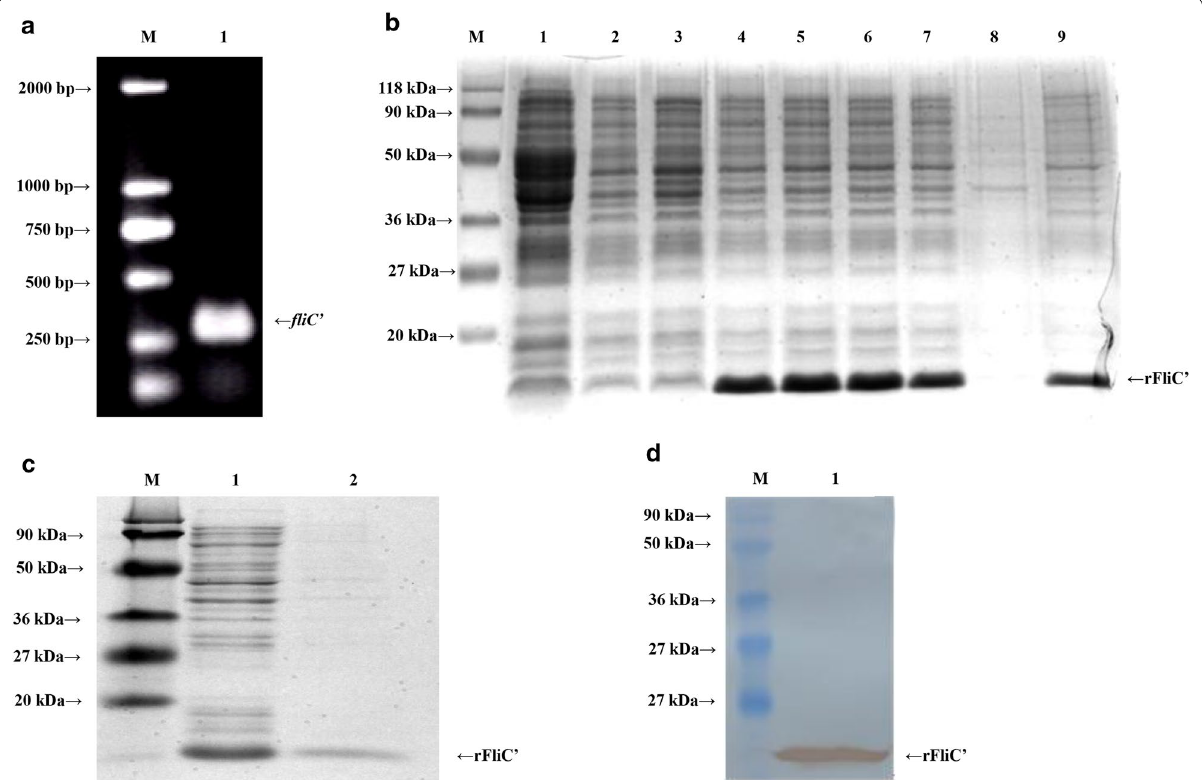
Fig. 1 Preparation and identification of recombinant rFliC ′ . a Analysis of fliC ′ fragment by agarose gel electrophoresis. Lane M, molecular weight marker; lane 1, PCR-amplified fliC ′ fragment. b Detection of the expression of rFliC ′ in E. coli BL21 (DE3) by SDS-PAGE. Lane M, protein molecular weight marker; lane 1, p ET22b ( ) vector control; lane 2, BL21 (DE3) control; lane 3–7, cell lysate of p ET- fliC after IPTG induction (0, 0.1, 0.4, 0.7 and + 1.0 mmol/L); lane 8, Cell lysate supernatant of p ET- fliC ; lane 9, cell lysate precipitation of p ET- fliC . c Analysis of the purity of the rFliC ′ by SDS-PAGE. Lane M, protein molecular weight marker; lane 1, p ET- fliC bacterial lysate; lane 2, purified rFliC ′ protein. d Identification of rFliC ′ by WB utilizing anti-His tag antibody. Lane M, protein molecular weight marker; lane 1, protein rFliC ′